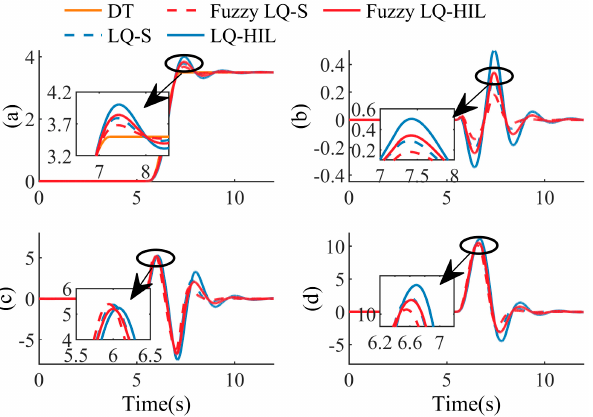
Figure 9. The control effect of single line-change condition. ( a ) Lateral displacement (m); ( b ) Lateral error (m); ( c ) Front-wheel angle (deg); ( d ) Yaw angle (deg).